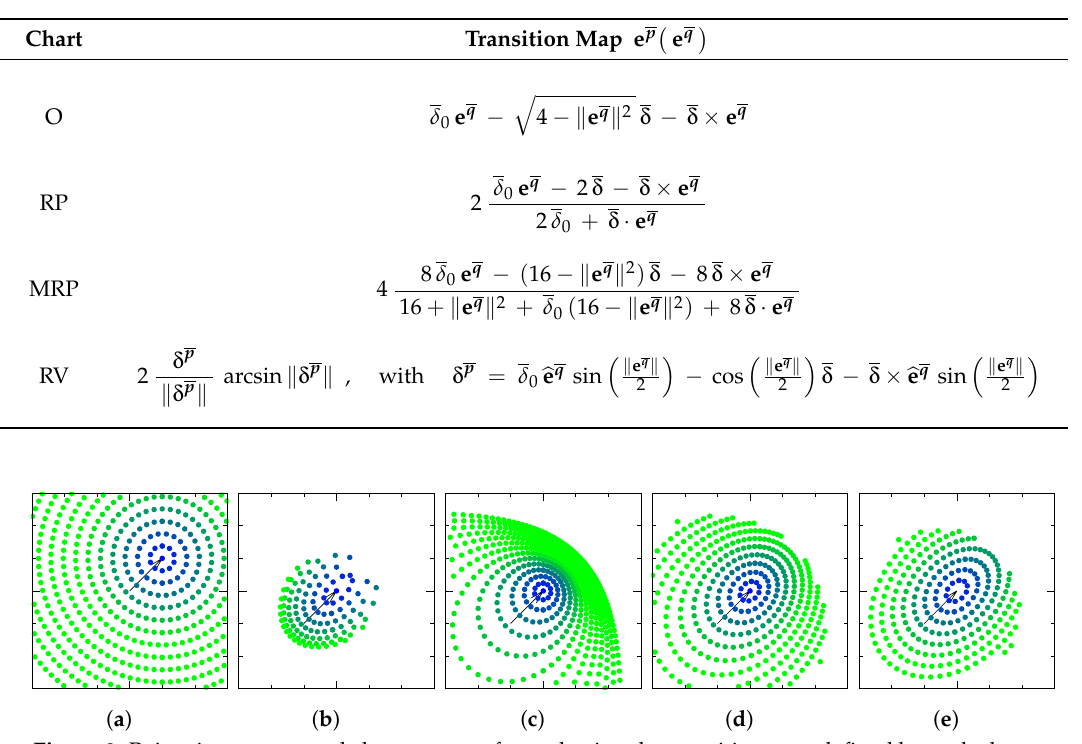
Table 3. Transition maps for the charts studied.